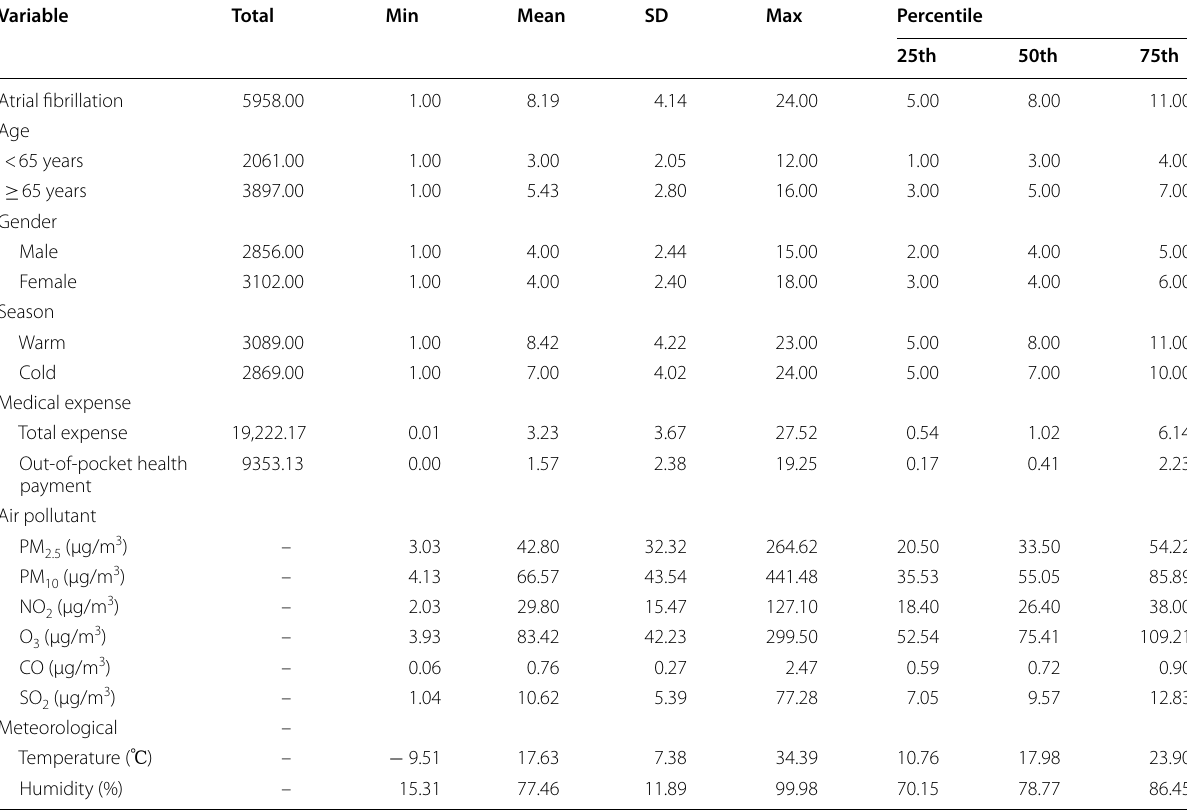
Unit: million Chinese Yuan (CNY). The annual economic costs were measured with a fixed price in 2018 Min Minimum, Max Maximum, SD Standard deviation, PM 2.5 an average aerodynamic diameter of less than 2.5 μm, PM 10 an average aerodynamic diameter of less than 10 μm, NO 2 nitrogen dioxide, O 3 ozone, CO carbon monoxide, SO 2 sulfur